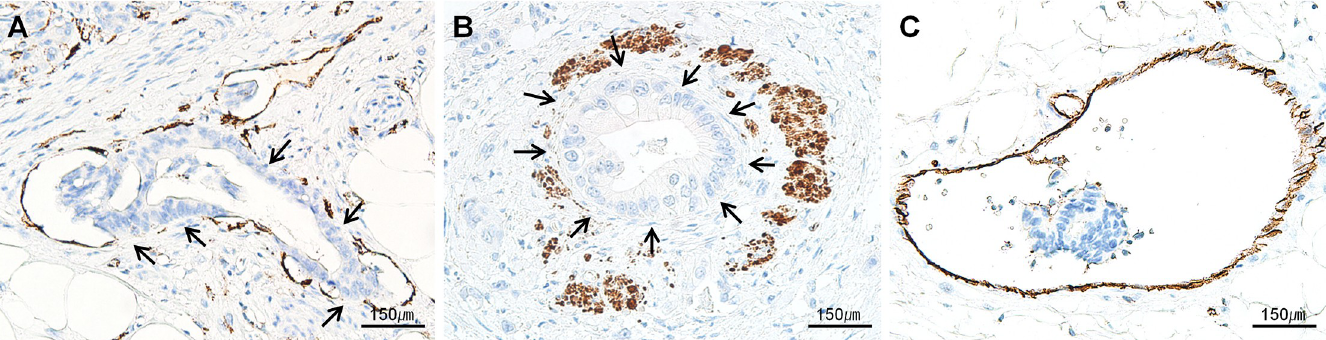
Fig 6. Representative images of CD31 immunolabeling of VI. (A) Partial loss of CD31 labeling (arrows) of endothelial cells where attachment of cancer cells on the endothelial portion. (B) Dual CD31 and desmin immunolabeling showing total loss of CD31 labeling on endothelial cells where attachment of cancer cells on the entire endothelial cells (arrows) with outer desmin positive smooth muscle of muscular vein. (C) Intact CD31 labeling of endothelial cells (all, × 400 magnification).